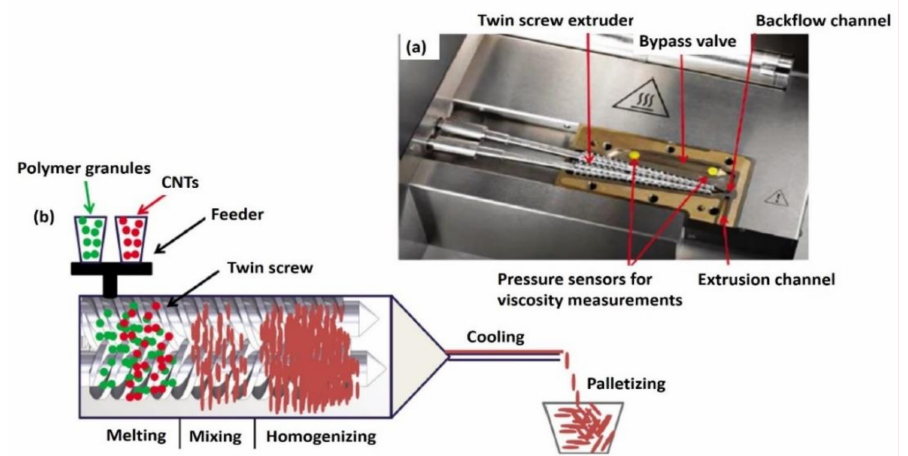
Figure 3. ( a ) View of micro-compounder with different valves and channels; ( b ) the schematic representation of a twin-screw extruder for the melt mixing of CNT-reinforced nanocomposites. Adapted from